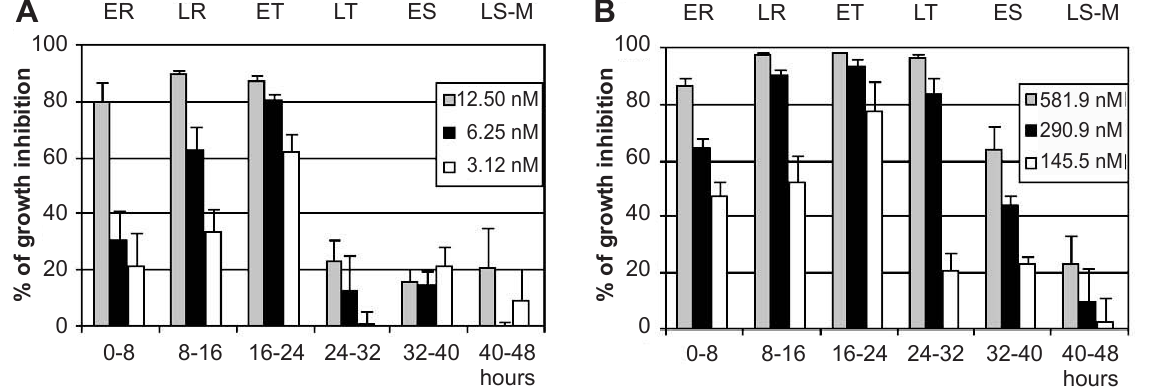
Table I. – In vitro activity of MB blue and classical antimalarials (alone or in combination) against different strains of P. falciparum .